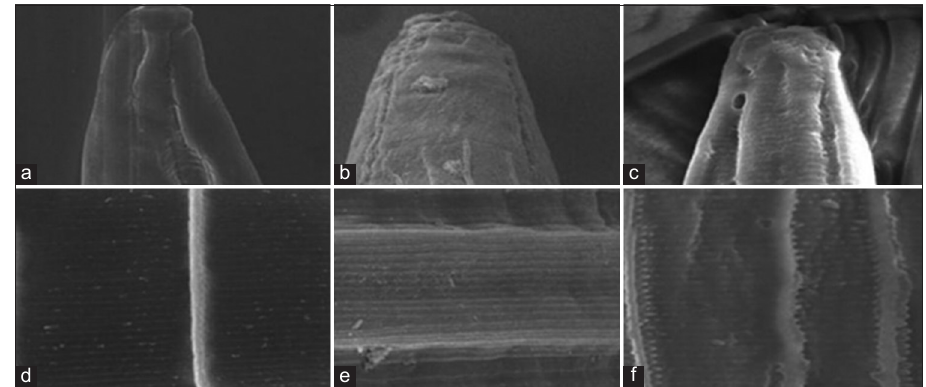
Figure-1: Scanning electron microscopy image of the anterior end and the cuticle of the adult female Haemonchus contortus . (a) and (d) The normal fresh worm; (b) and (e) the worm after incubation with E.E.B.; and (c) and (f) the worm after incubation with